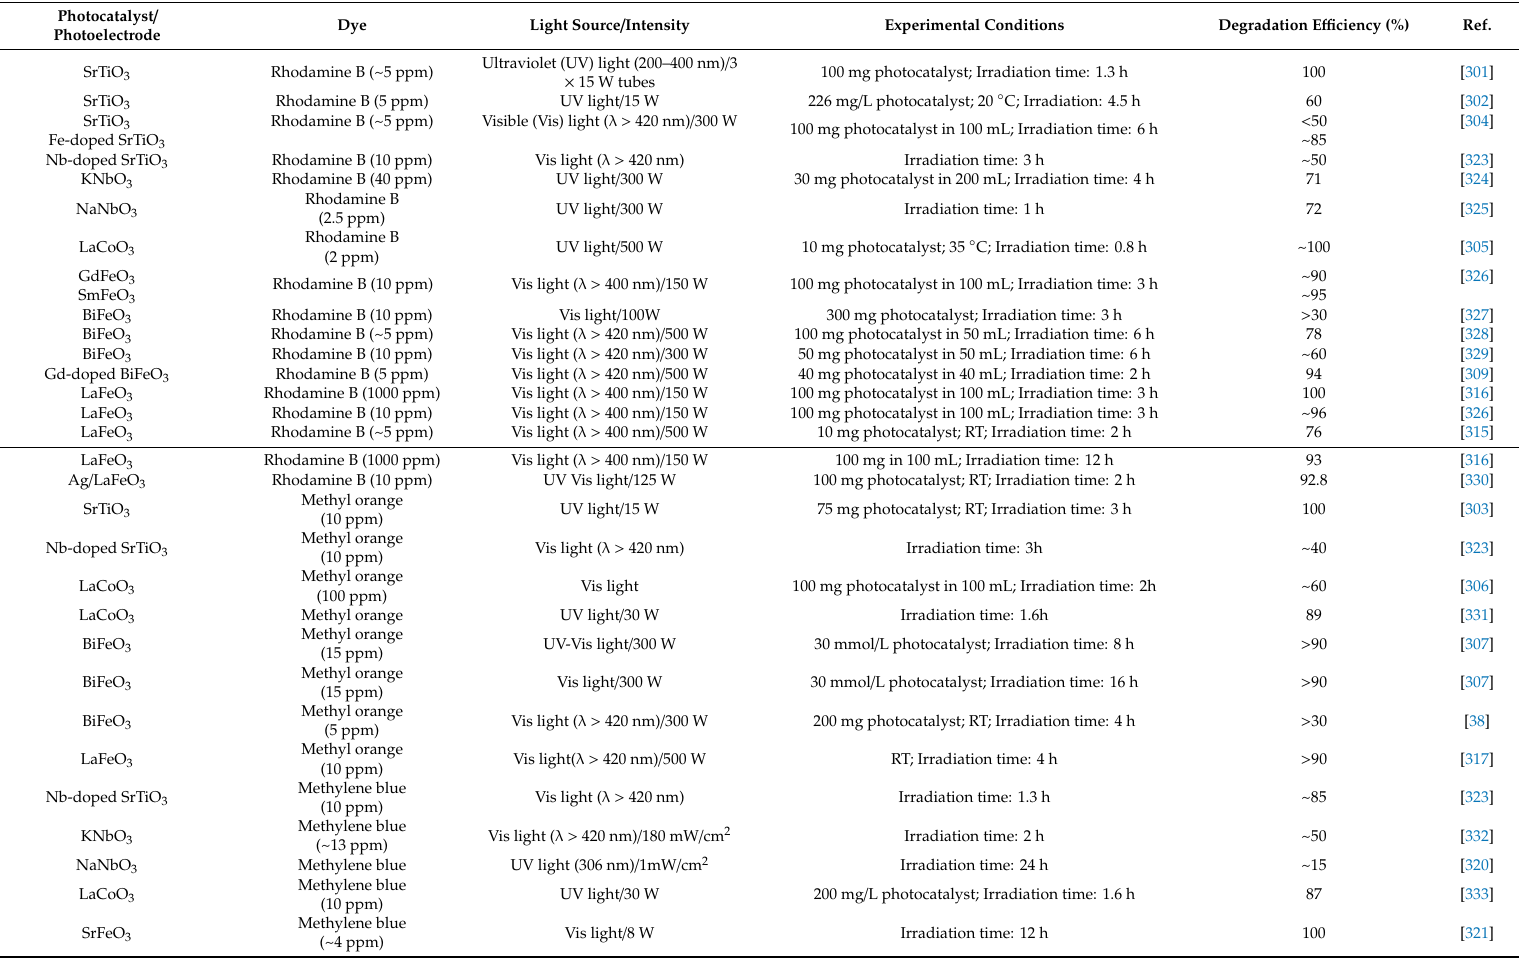
Table 13. The performances of complex oxides having perovskite-type structure in the photodegradation of organic dyes. Photocatalyst /